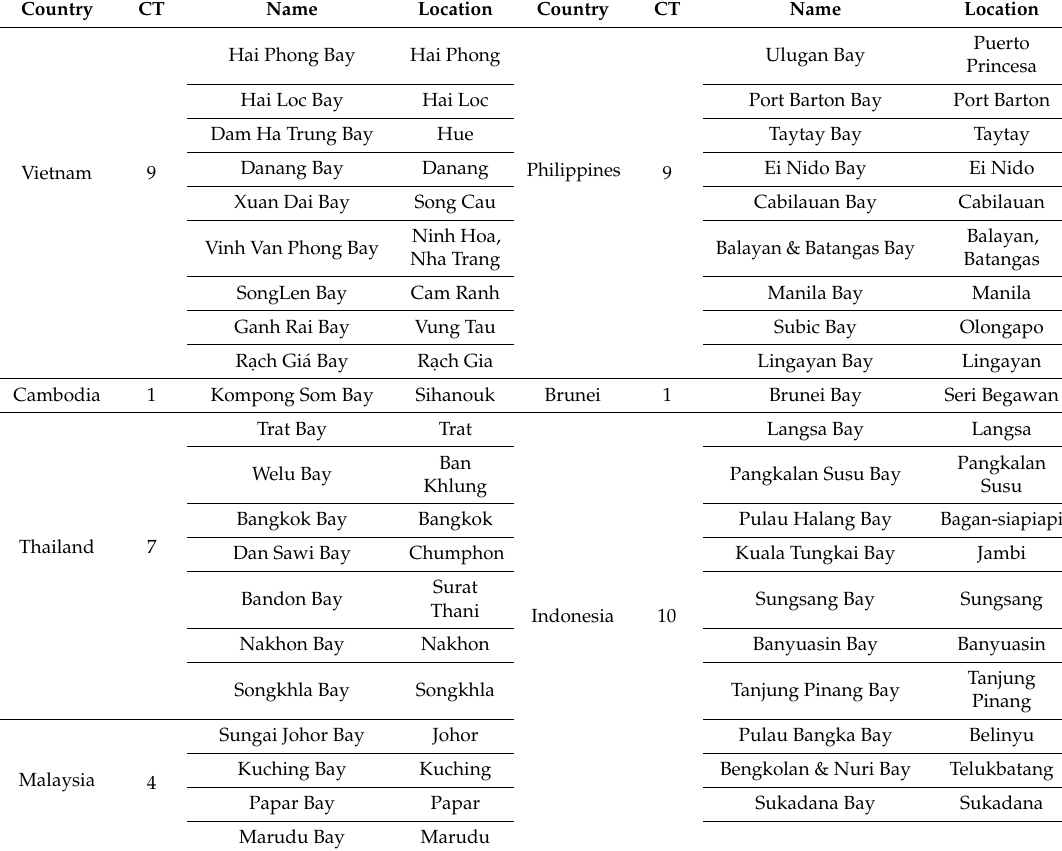
Table 2. Major bays surrounding the South China